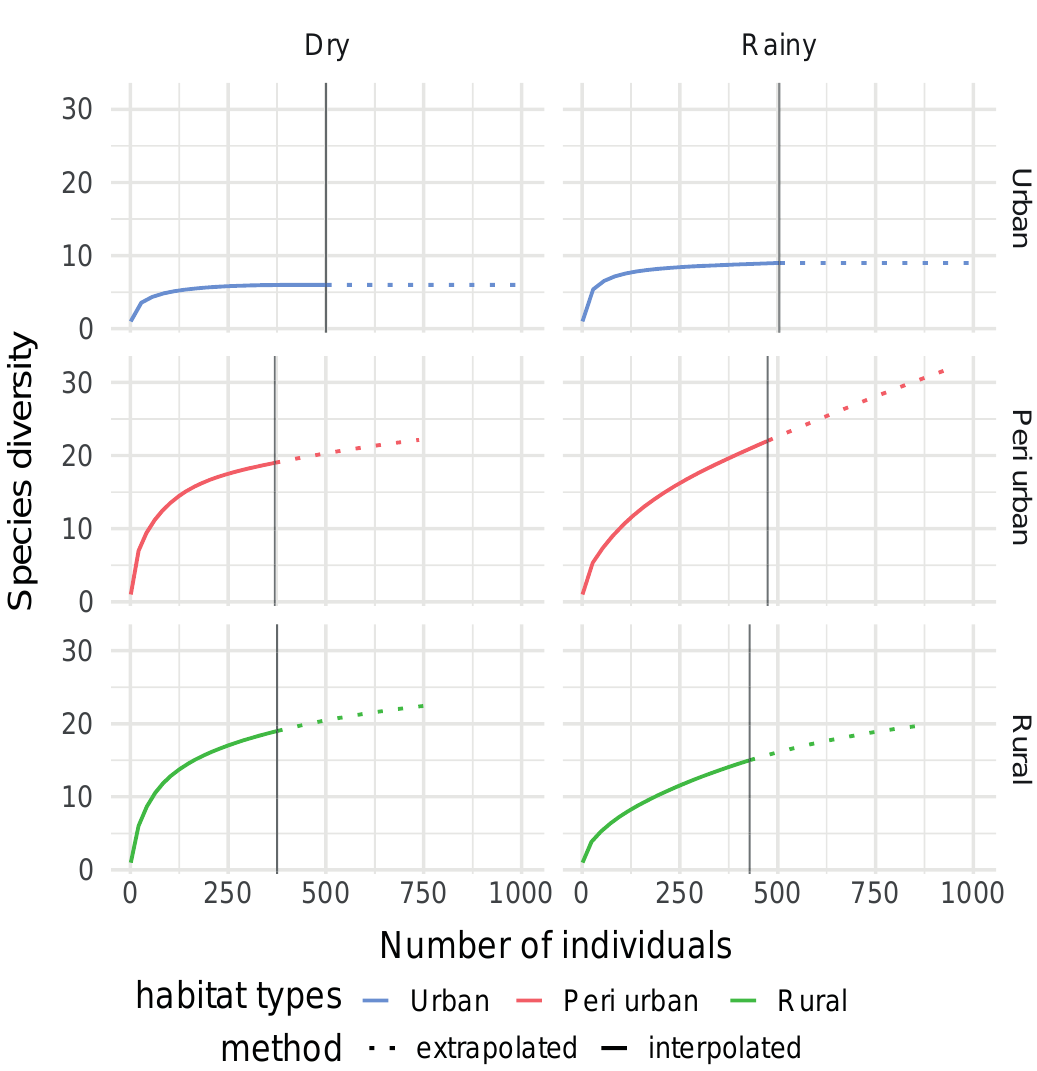
Figure 6. Individual-based rarefaction curves comparing species richness across habitats and seasons in Dschang, West-Cameroon.